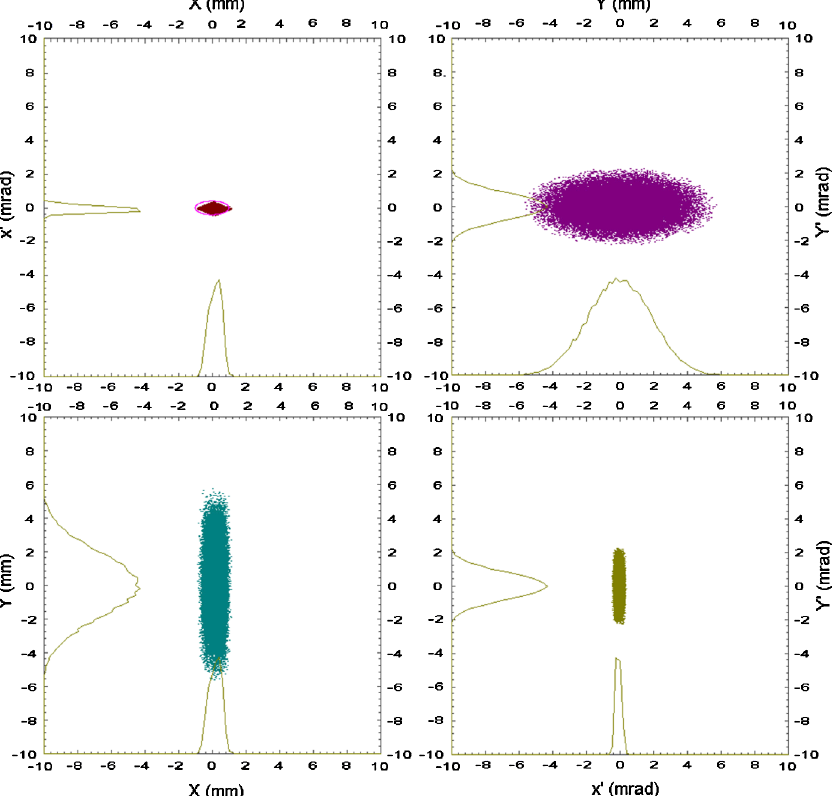
FIG. 4. (Color) Beam distributions in phase spaces at the entrance of the beam rotation section. The initial distributions at the extraction deflector are irregular in the horizontal phase plane and Gaussian in the vertical phase plane, with rms emittances of 0 : 04 (cid:1) mm mrad and 1 : 34 (cid:1) mm mrad , respectively. The beam is matched to (cid:5)